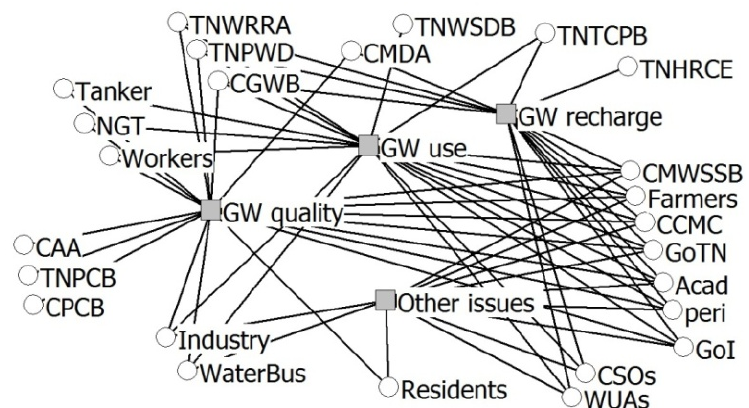
Figure 2. Stakeholders and their groundwater-related